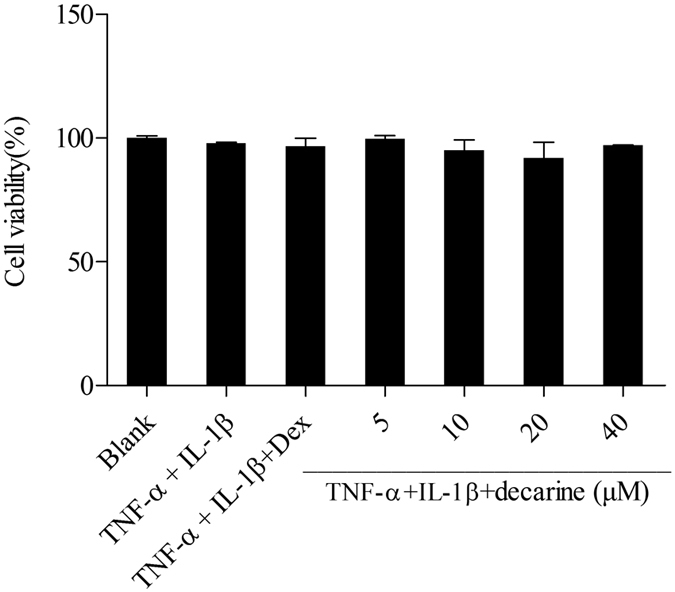
Effect of decarine on the cell viability of Caco-2 cells.All values were means ± SD, n = 3. Dex: dexamethasone; IL-1β: interleukin-1β; TNF-α: tumor necrosis factor-alpha.